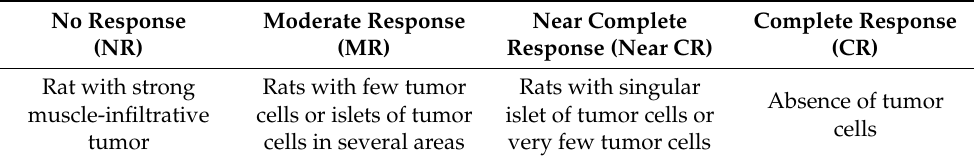
Table 1. Tumor response grades (adapted with modification from [30]).